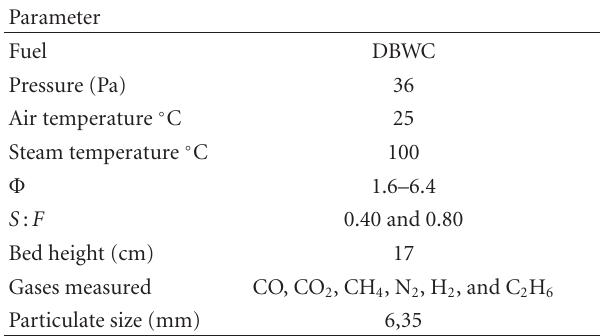
Table 2: Experimental